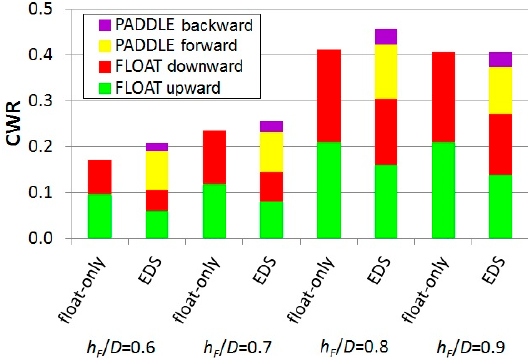
Figure 14. Comparison between CWR of EDS and float -only system at best configuration.